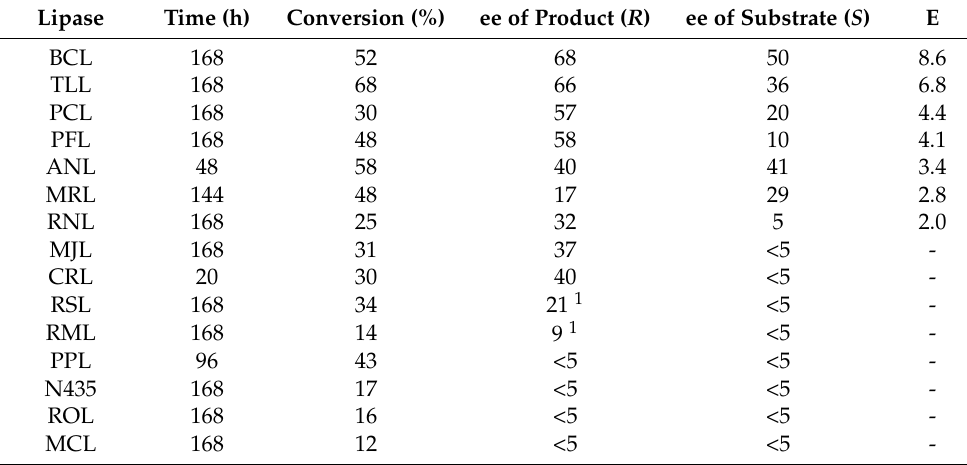
Table 2. Lipase-catalyzed hydrolysis of dibutyl 1-butyryloxy-1-carboxymethylphosphonate 2b . Lipase